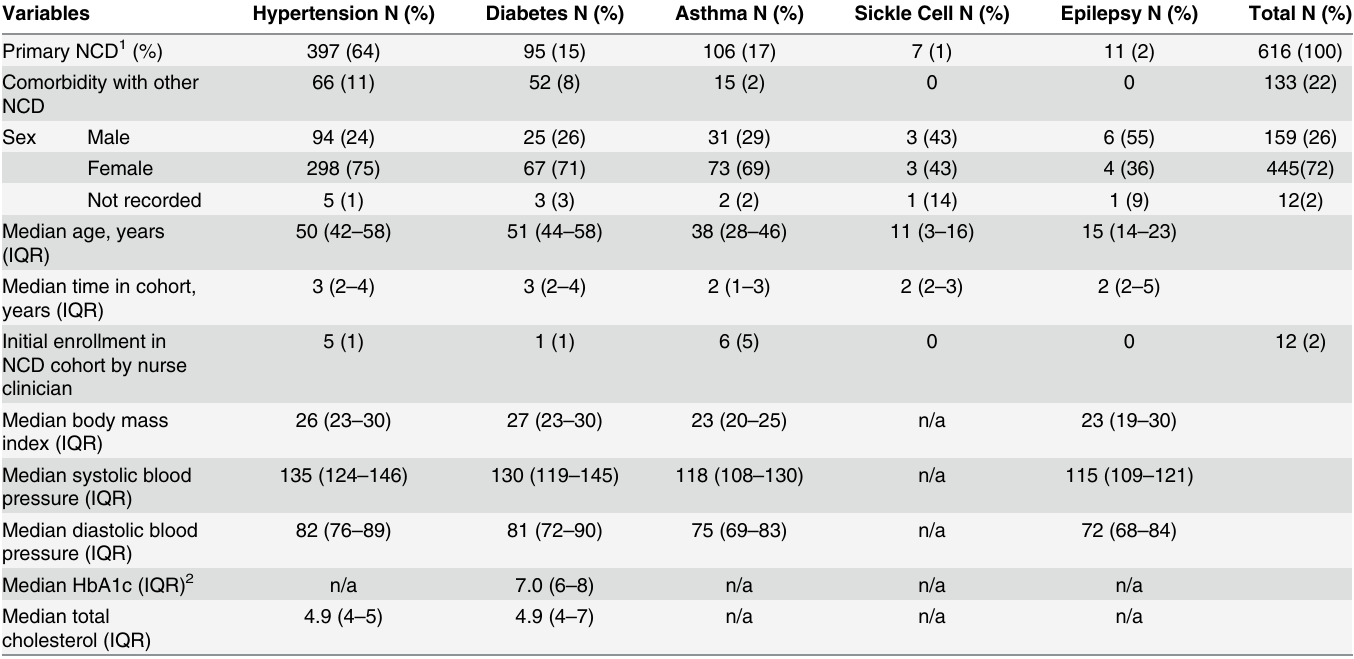
Table 1. Socio-demographic and clinical characteristics of individual non-communicable disease patients at first nurse clinician consultation in two integrated primary health care clinics in Kibera, Kenya (May-August